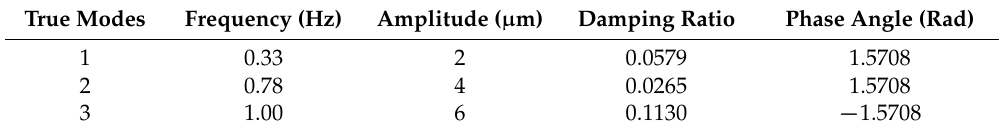
Table 1. Modal parameters of the ideal simulated signal.